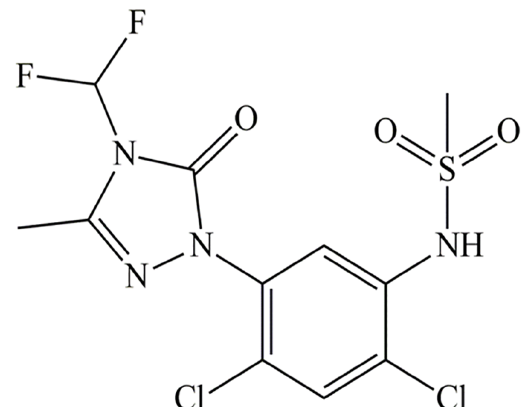
Figure 1. Molecular structure of the Sulfentrazone